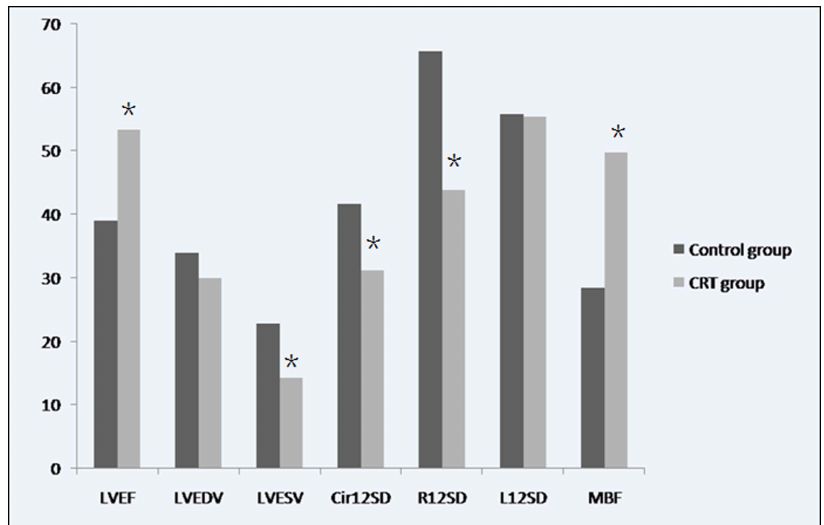
Figure 1. An illustration of LVEF, LVEDV, LVESV, Cir12SD, R12SD, L12SD, and MBF between control group and CRT group at 4 weeks after CRT. The LVEF, LVESV, Cir12SD, R12SD, and MBF were improved in CRT group. LVEF 5 left ventricular ejection fraction; LVEDV 5 left ventricular end diastolic volume; LVESV 5 left ventricular end systolic volume; Cir12SD 5 standard deviation of the time-to-peak of the transmural regional circumferential strain; R12SD 5 standard deviation of the time-to-peak of the transmural regional radial strain; L12SD 5 standard deviation of the time-to-peak of the transmural regional longitudinal strain; MBF 5 myocardial blood flow.